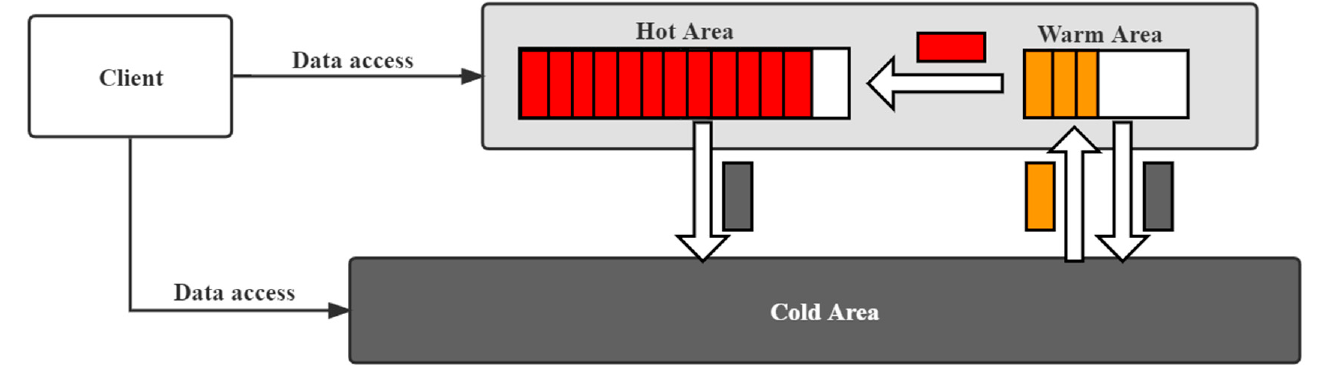
Figure 10. Data dynamic management model data replacement idea.